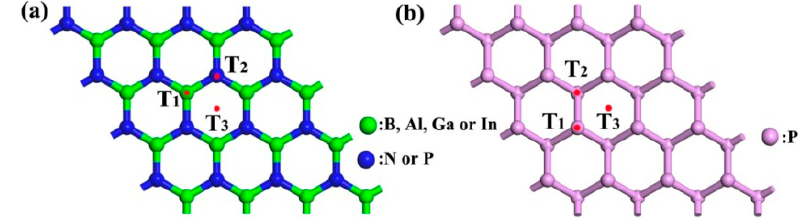
Figure 1. Three representative initial adsorption sites for ( a ) boron nitride (BN), (aluminum nitride) AlN, (gallium nitride) GaN, (indium nitride) InN, and boron phosphide (BP) and for ( b ) phosphorus (P).